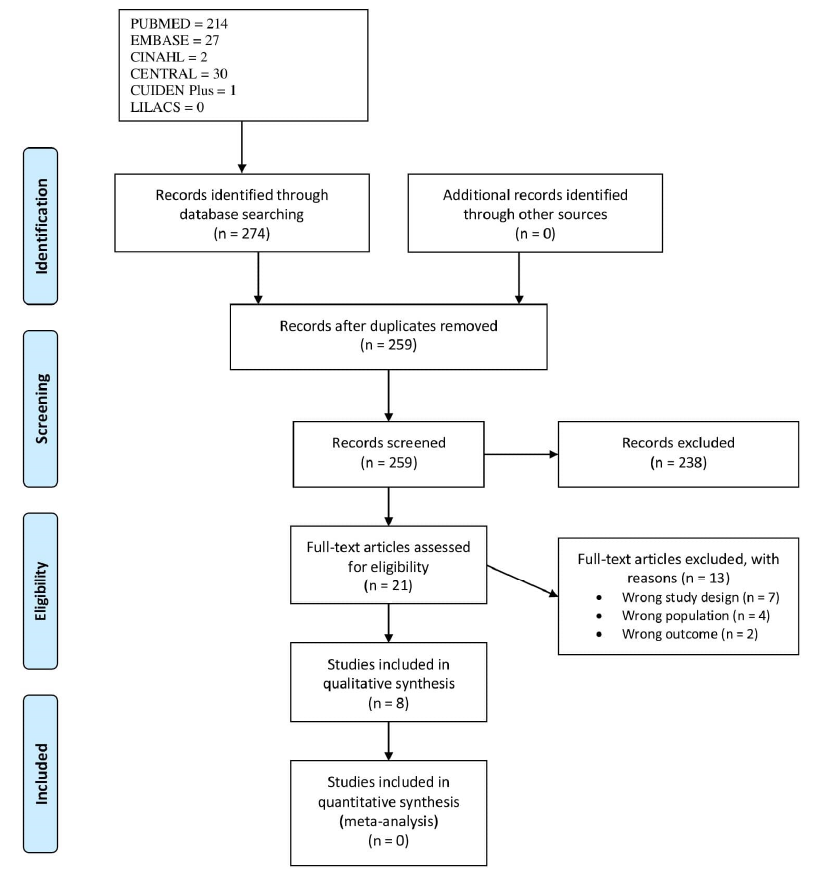
Figure 1. PRISMA Flowchart.